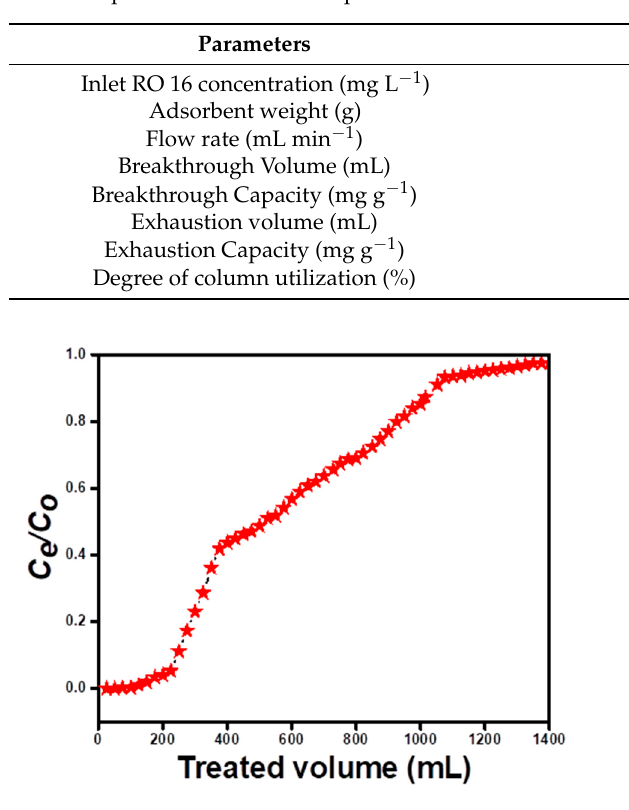
Table 5. Operational and derived parameters for RO 16 Column adsorption by m-CGPA.